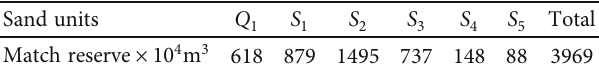
Table 6: Reserve matching result of Shansan 3D model. Sand